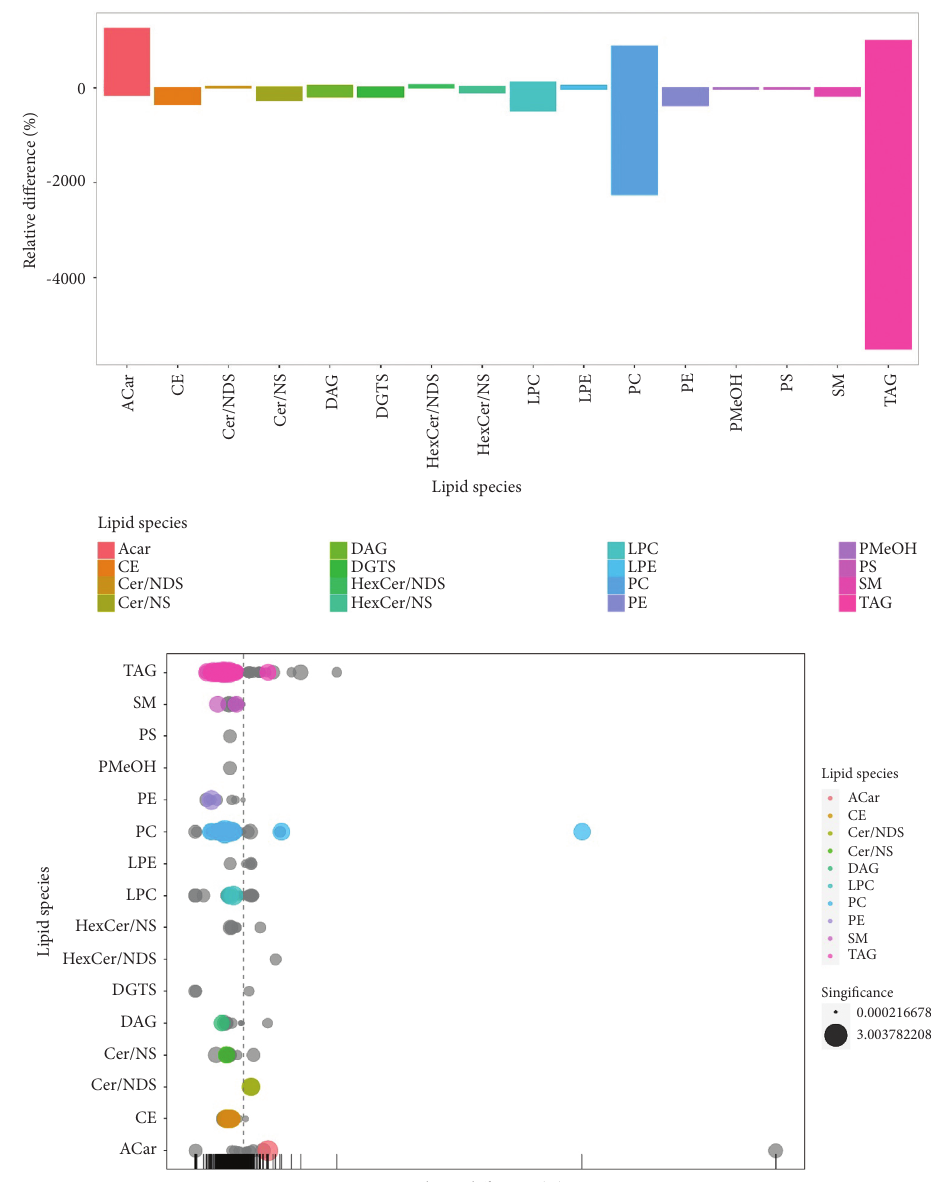
Figure 9: Histogram and bubble plot of lipid group in ordinary rice group-high dose reconstituted rice group (positive ion